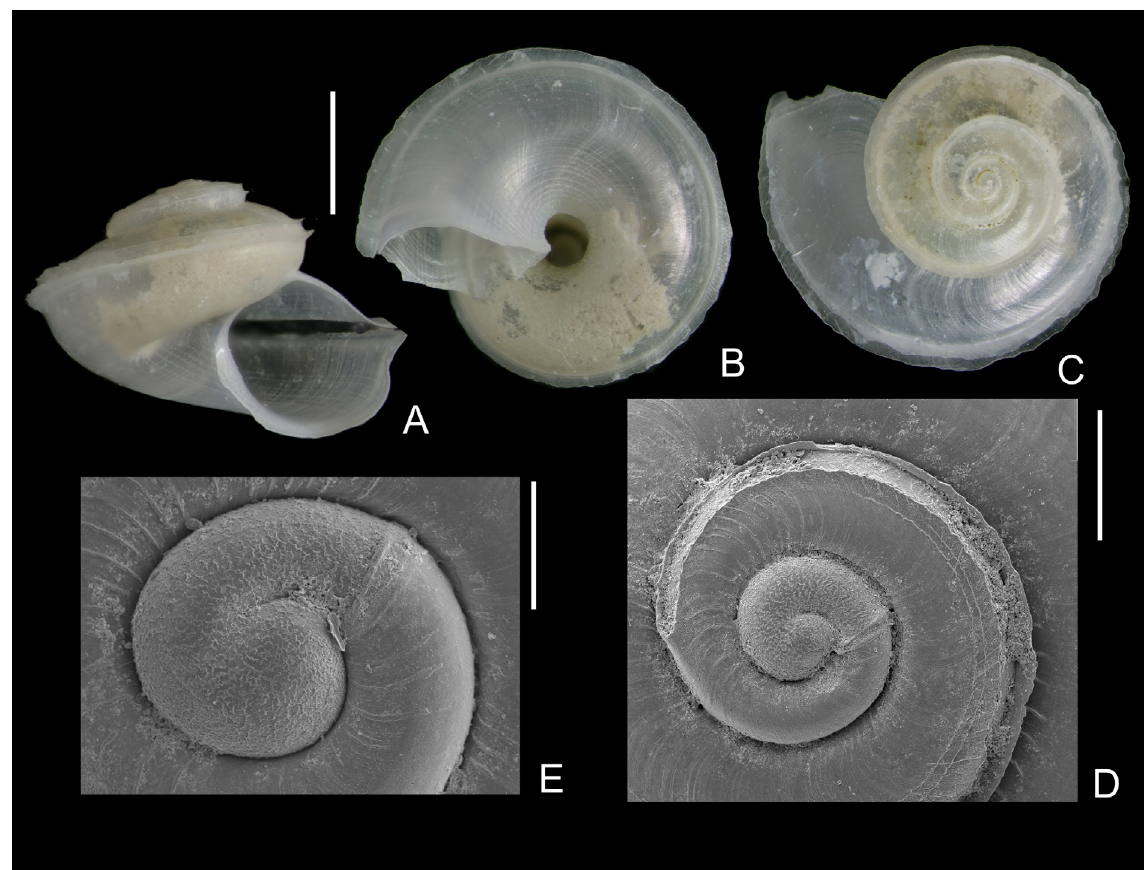
Fig. 9. Anatomidae 3. A–C . Anatoma umbilicata (Jeffreys, 1883), BANGAL 0711, V10, 1720 m, diameter 3.1 mm. D–E . Details of protoconch and early teleoconch whorls of another shell, same locality. Scale bars: A–C = 1 mm; D = 200 µm; E = 100